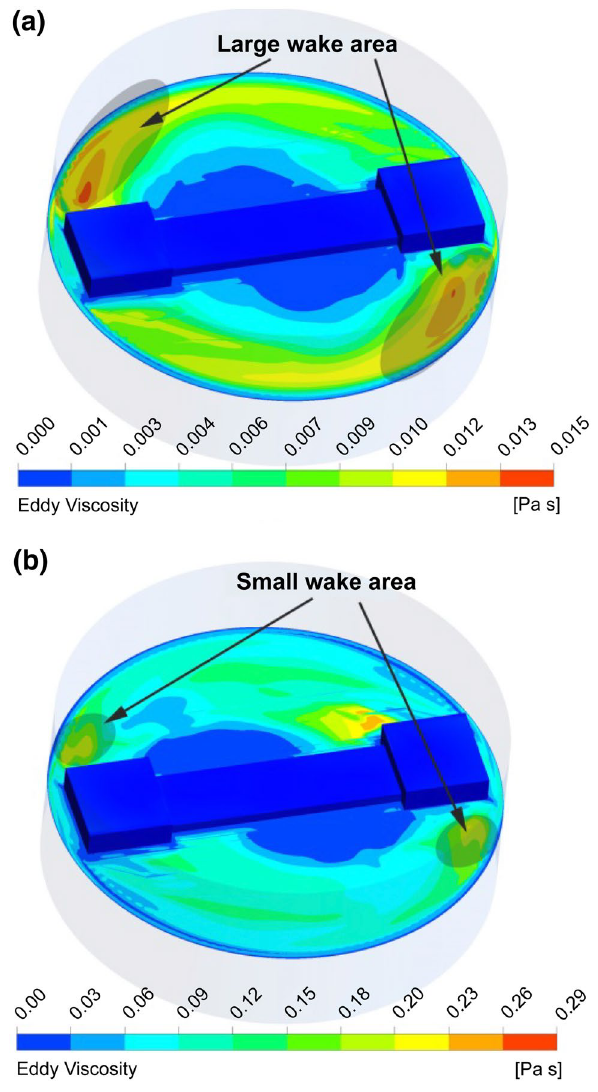
Fig. 12 Effective dynamic cloud image of the A–A cross-section at a 5000 Pa and b atmospheric pressure